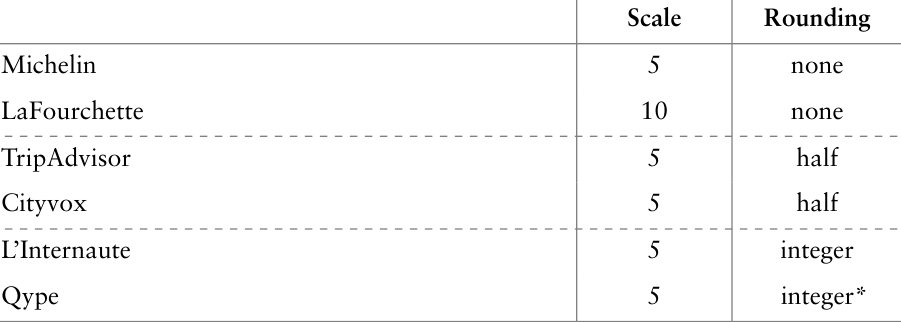
Table 11. Rounding policy of OCR websites.